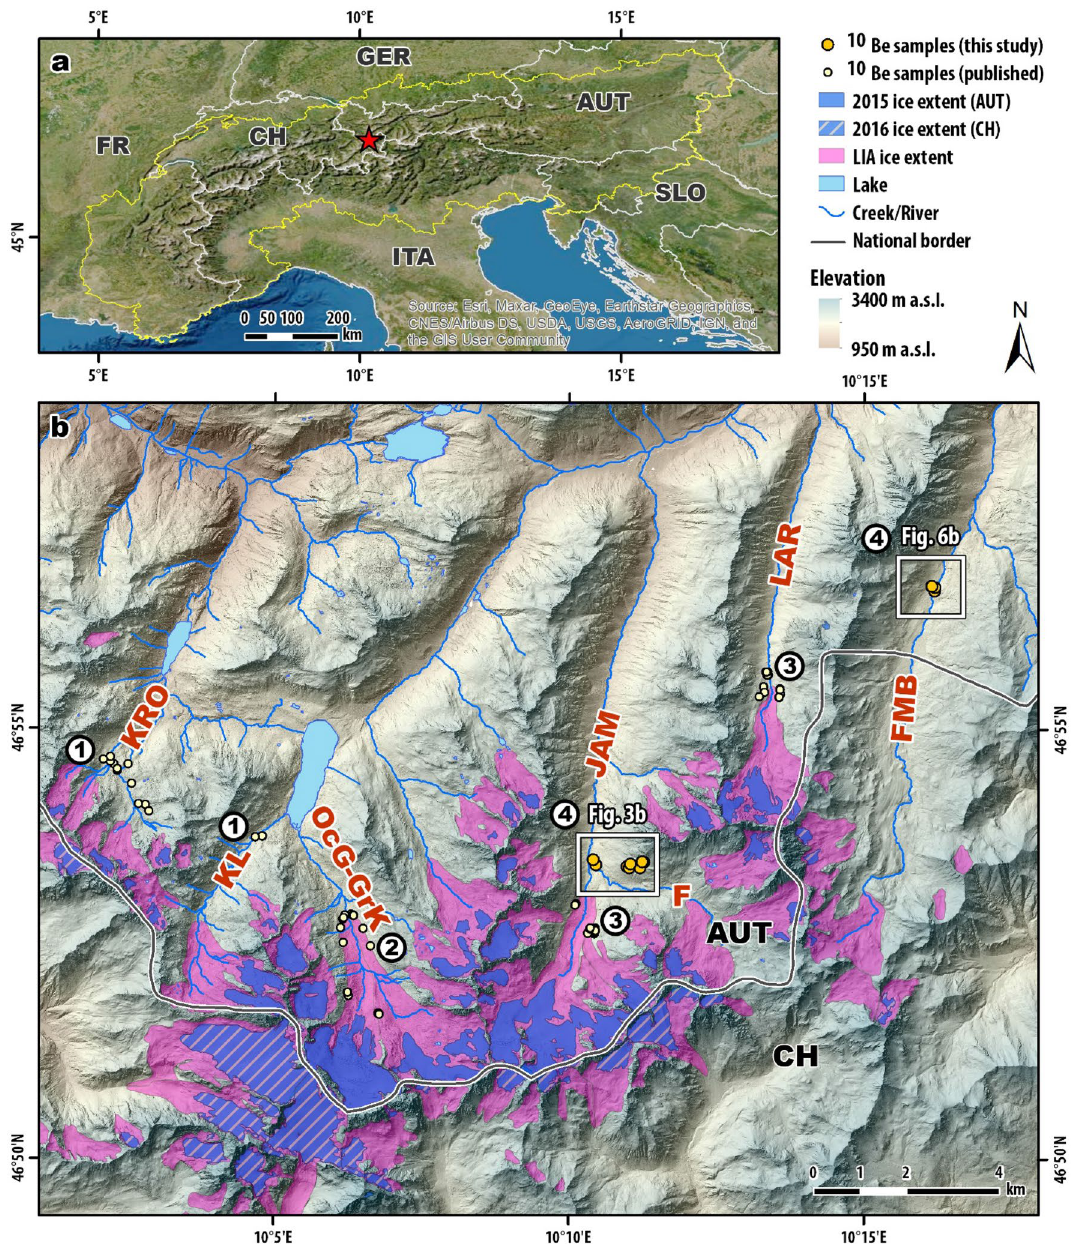
Figure 1. Location of study sites. (a) Overview of the European Alps (yellow line); red star symbol marks Silvretta region, a glaciated area at the transition zone between the Western and the Eastern Alps. Sattelite image provided by © 2020 Esri and its licensors (https:// servi ces. arcgi sonli ne. com/ ArcGIS/ rest/ servi ces/ World_ Image ry/ MapSe rver). ( b ) Investigated valleys in the north-facing part of the Silvretta region. Ice extents during the Little Ice Age (LIA) are depicted in pink; modern glacier extents are indicated with blue signature (glacier extents of 2016 for Switzerland CH; glacier extents 2015 for Austria AUT) 15–17 . DEMs provided by ©swisstopo (https:// www. swiss topo. admin. ch/ en/ geoda ta/ height/ alti3d. html), Land Tirol (www. tirol. gv. at/ als; CC BY 4.0), and Land Vorarlberg (https:// vogis. cnv. at/ atlas/ init. aspx; CC BY 4.0). Valleys with previously